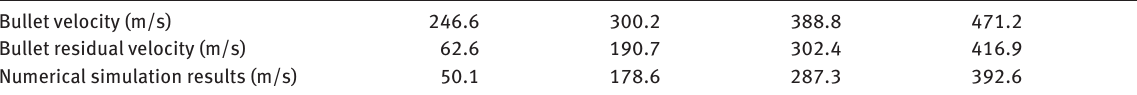
Table 3: Comparison of bullet residual velocity numerical simulation results and experimental results. Bullet velocity (m/s)